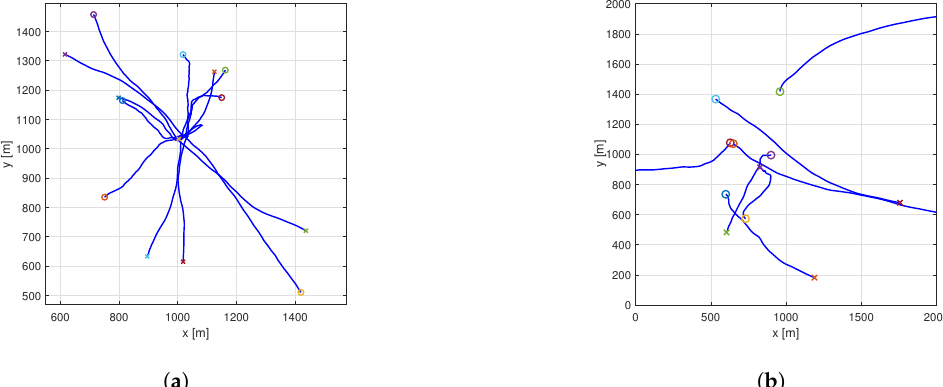
Figure 2. Example scenario ground truth for the crossing trajectories ( a ) and the random trajectories ( b ) simulation. Starting positions are marked with circles, ending positions are indicated by